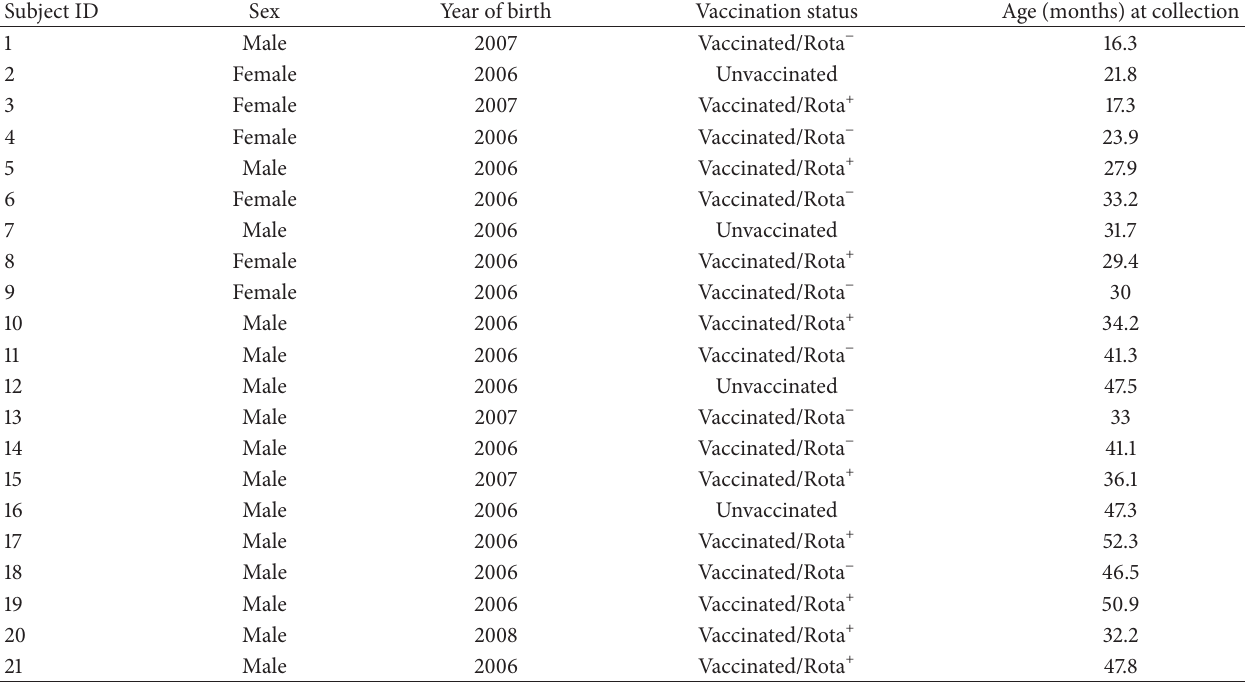
Table 1: Subject demographics. Demographics of study subjects include gender, year of birth, vaccination status, and age in months at sample collection. Rota − , vaccinated but not against rotavirus; Rota + , fully vaccinated including against